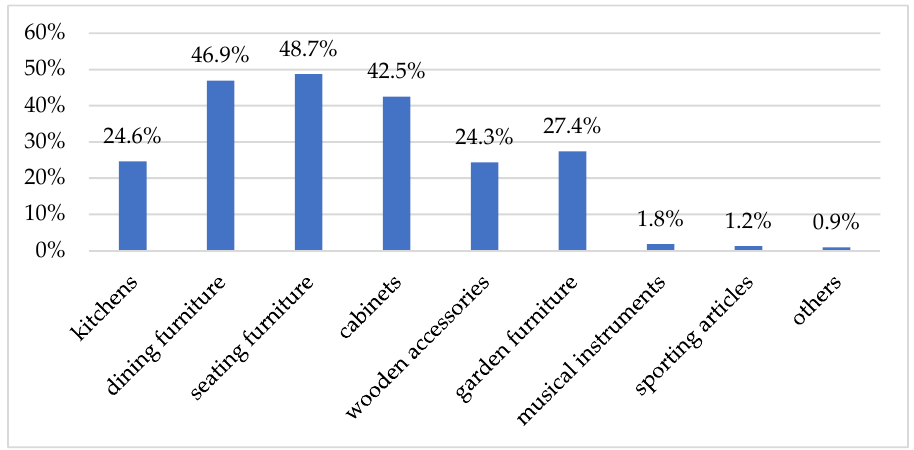
Figure 5. Preferred types of beech wood products by consumers.